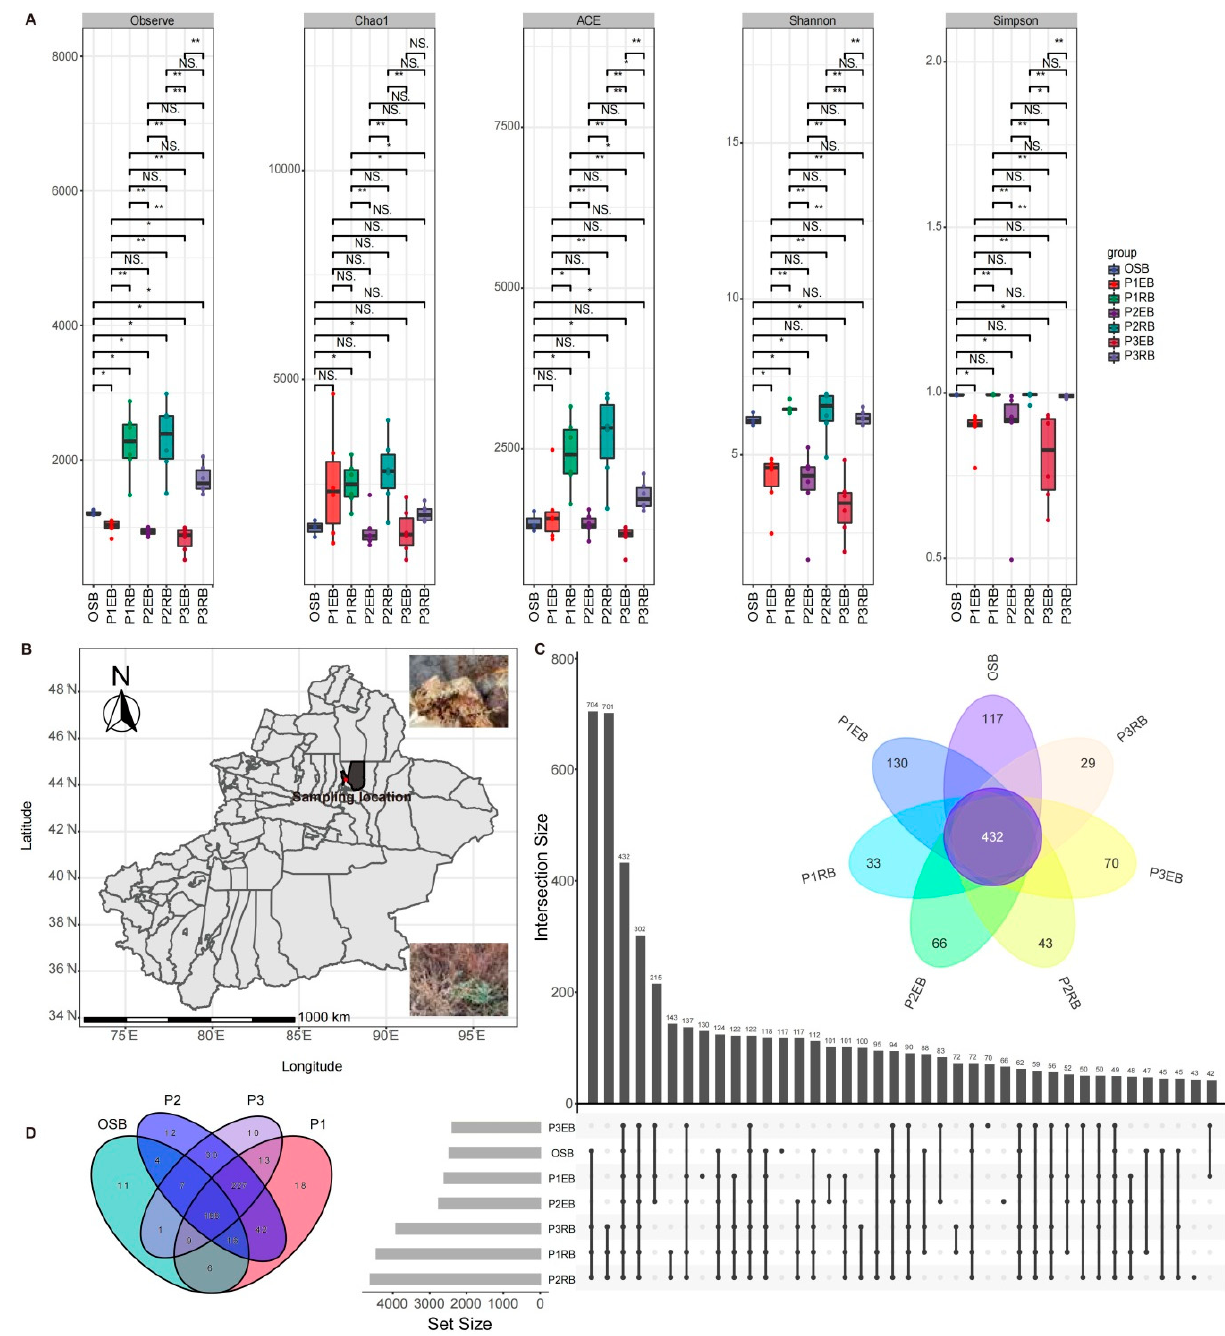
Figure 1. ( A ) The significant difference (Wilcoxon test, p < 0.05) in alpha diversity of endophytic bacteria and rhizospheric bacteria associated with three halophytes; ( B ) a map showing sampling location; ( C ) the UpSet view and flower plot showing the shared and special OTUs among different samples; ( D ) the Venn plot showing the shared and exclusive OTUs between OSB and three different halophytes. Note: NS. means no significant differences, * p < 0.05, ** p < 0.01.